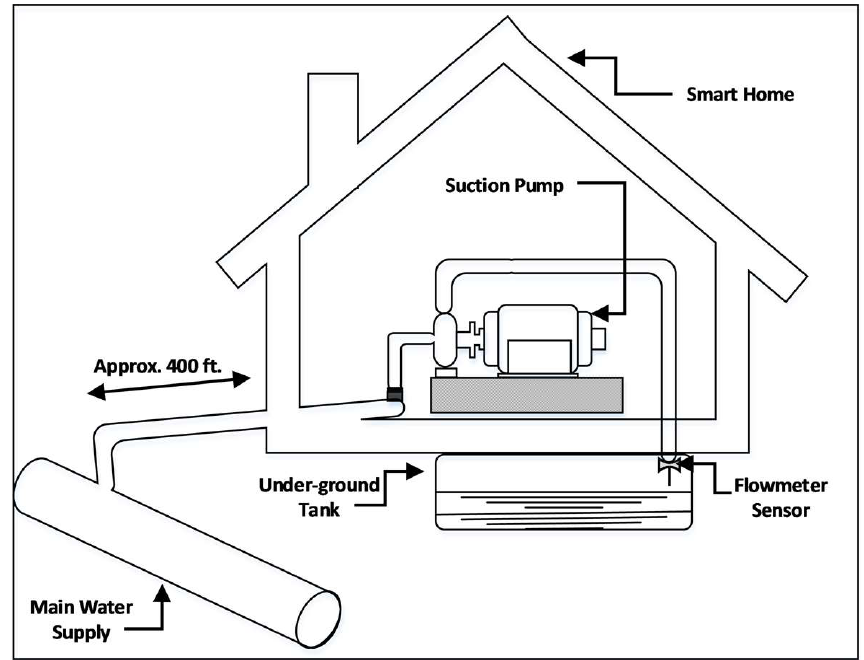
Figure 1. Depiction of key components of